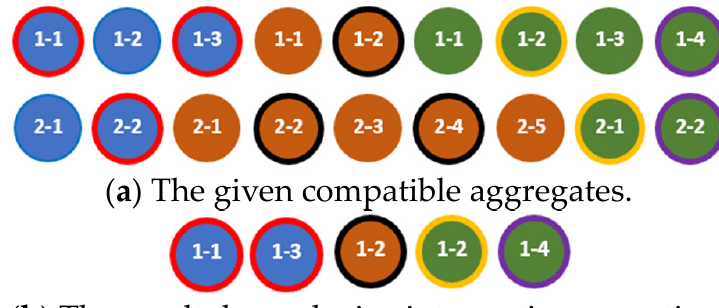
( b ) The result the exclusive intersection operation. Figure 8. An example of applying the exclusive intersection operation to two compatible aggregates.